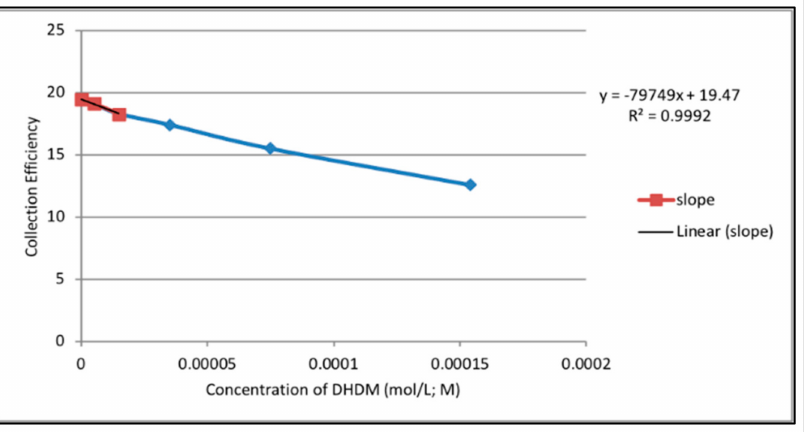
Figure 31. Collection efficiency for